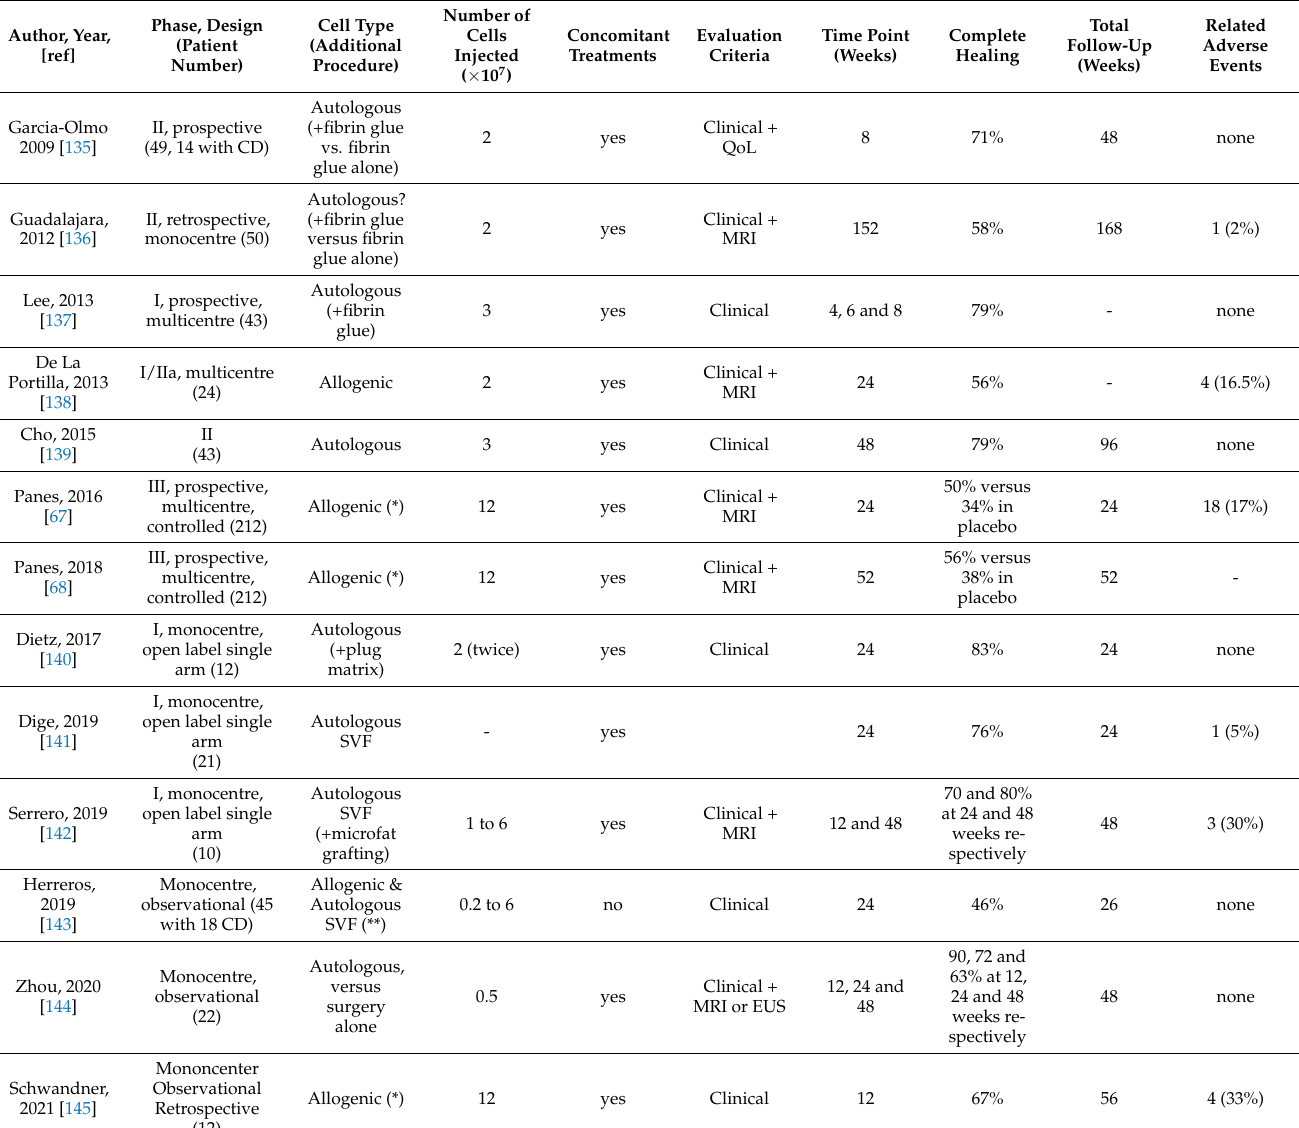
Table 1. Main published studies that included patients with anoperineal fistula in Crohn’s disease who were injected in situ with adipose-derived stem